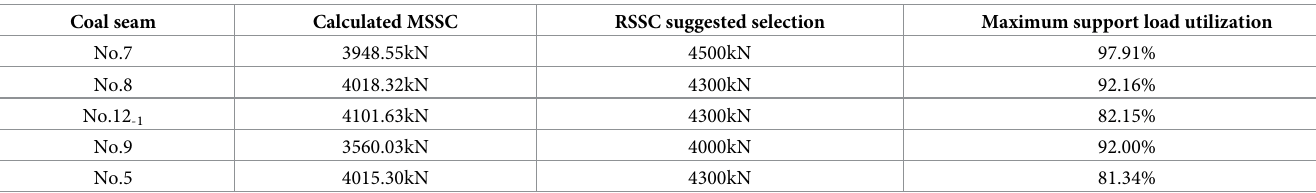
Table 18. SSC results of calculation in each coal seam.